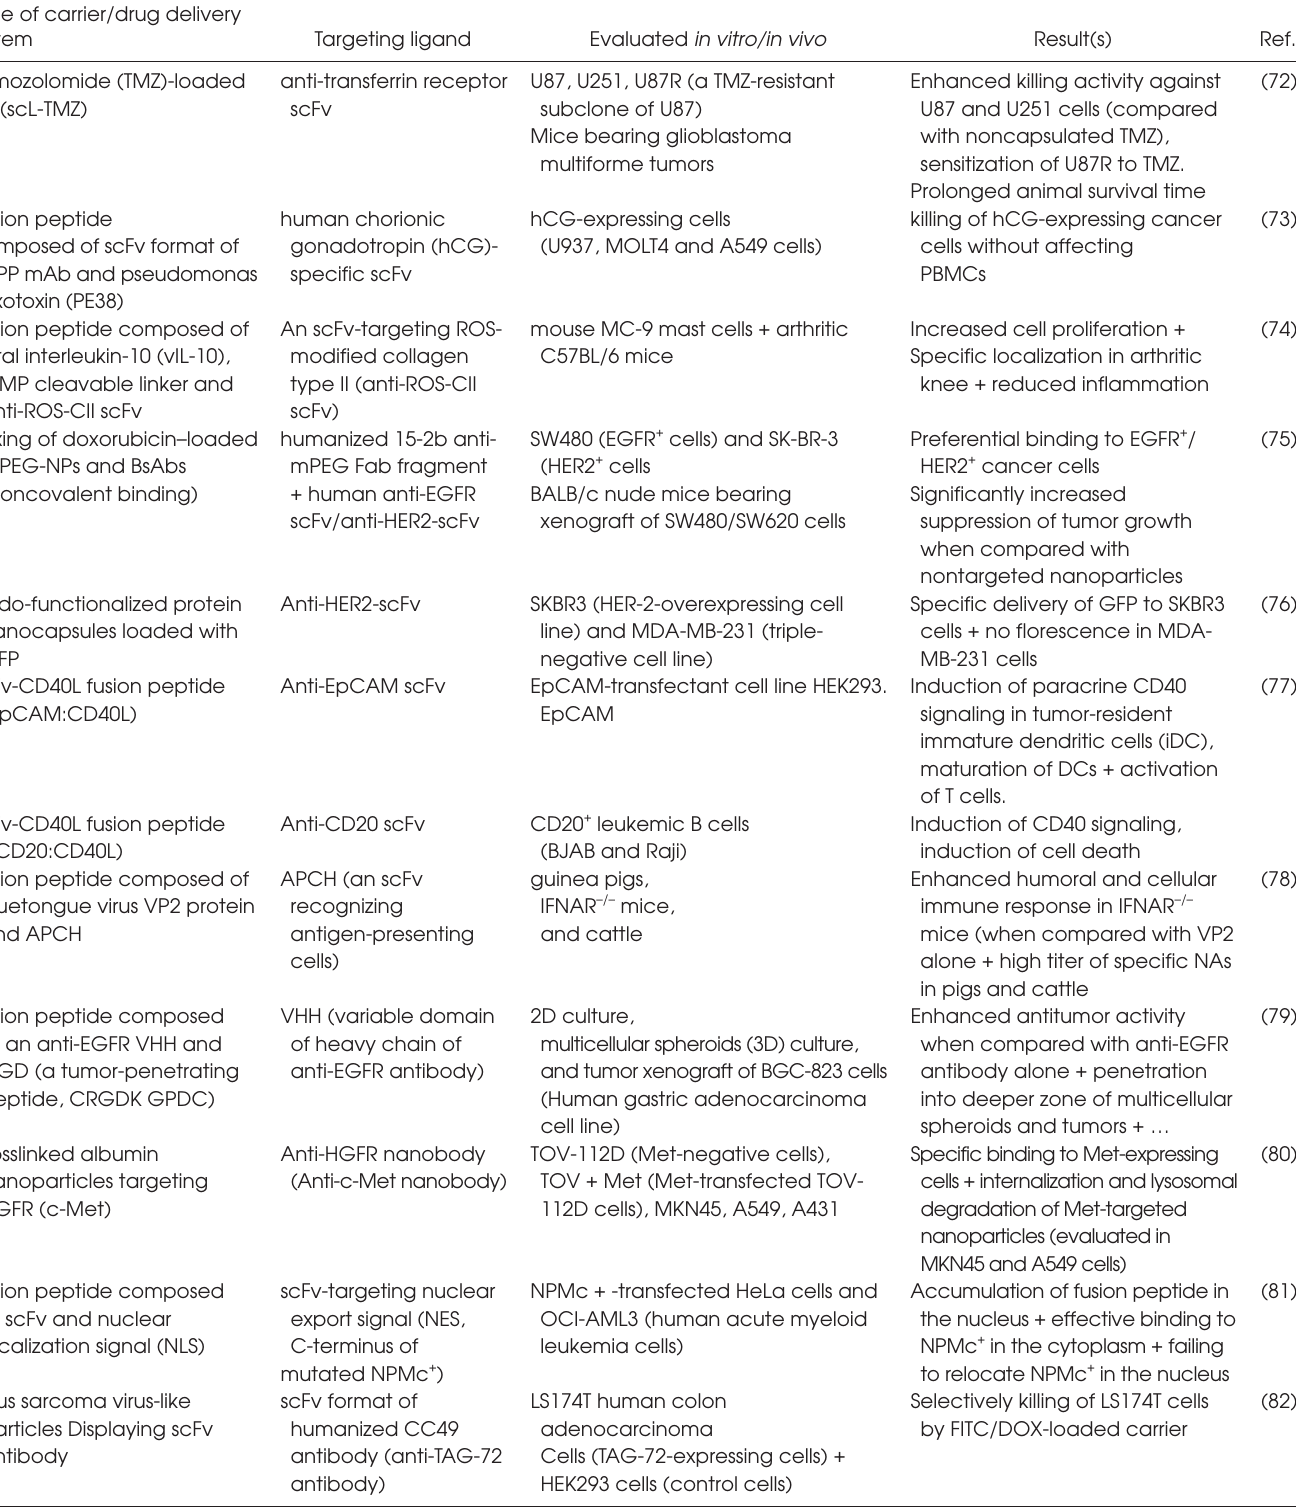
Table 1. Summary of a number of studies concerning the use of single-chain antibodies in drug delivery systems. Type of carrier/drug delivery